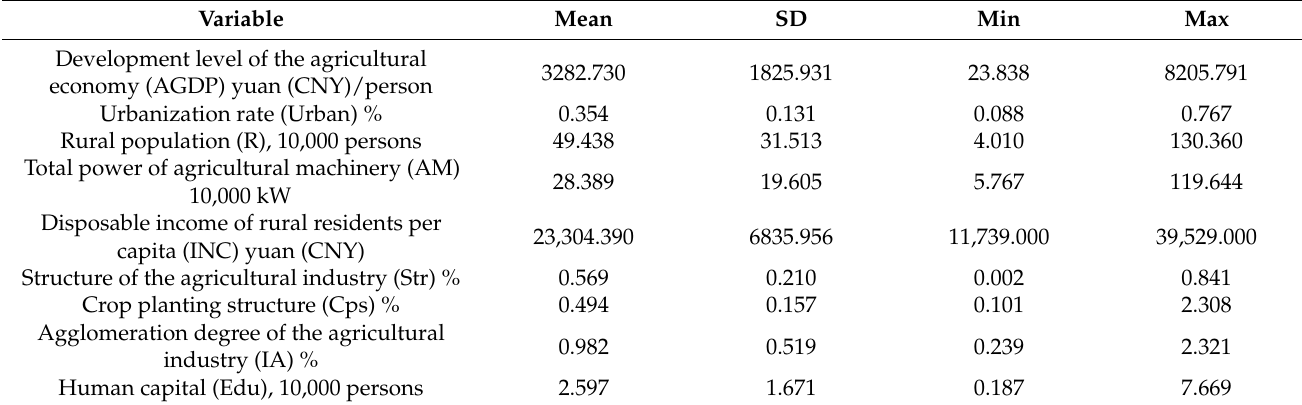
Table 2. Selection and descriptive statistics of variables affecting the ACESs in the